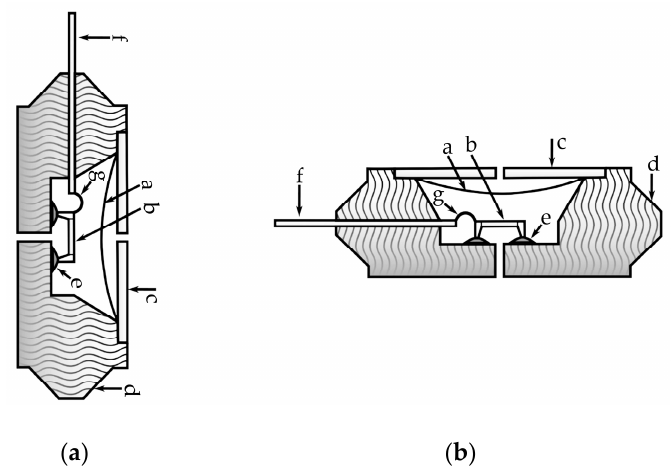
Figure 5. Sensor positioning scheme for testing the e ff ect of static acceleration on the output signal from the transducer: ( a ) position indicating zero e ff ect of static acceleration on the membrane structure; ( b ) position representing a 90 degree change in the position of the transducer (indicating a maximum e ff ect of static acceleration on the diaphragm structure).